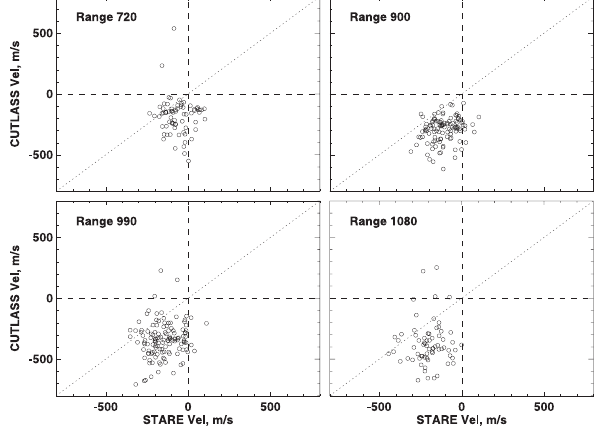
Fig. 8. Scatter plot of Hankasalmi CUTLASS velocity versus Fin- land STARE velocity at several slant ranges for the period of 11:00– 14:00UT when CUTLASS (STARE) radar observed echoes from the F- (E)-region.